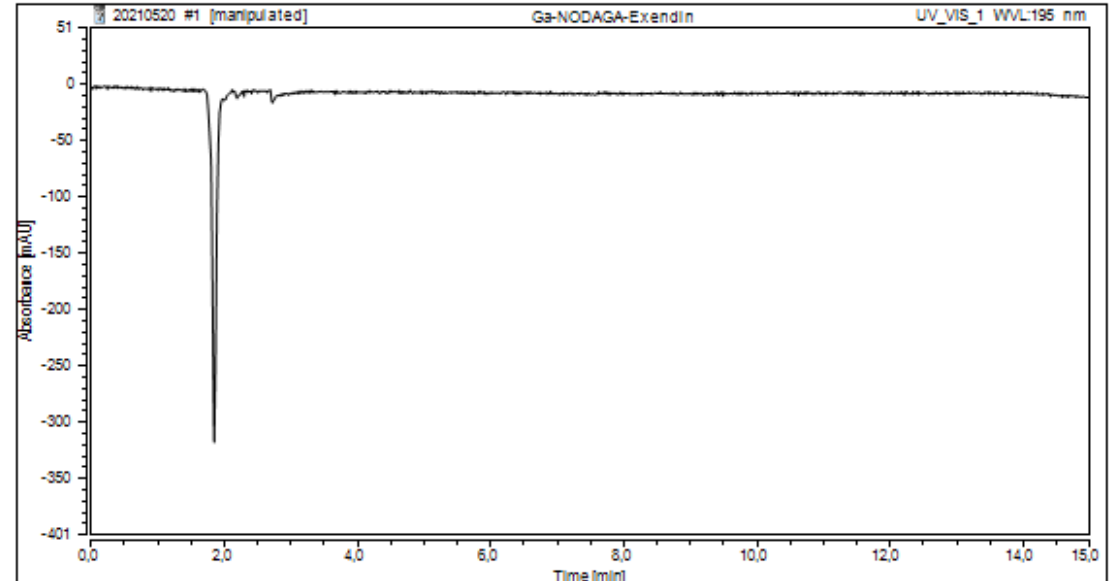
Figure 6. HPLC chromatogram of “cold” Ga-NODAGA-Exendin-4 to assess the content of HEPES in the final radiopharmaceutical.